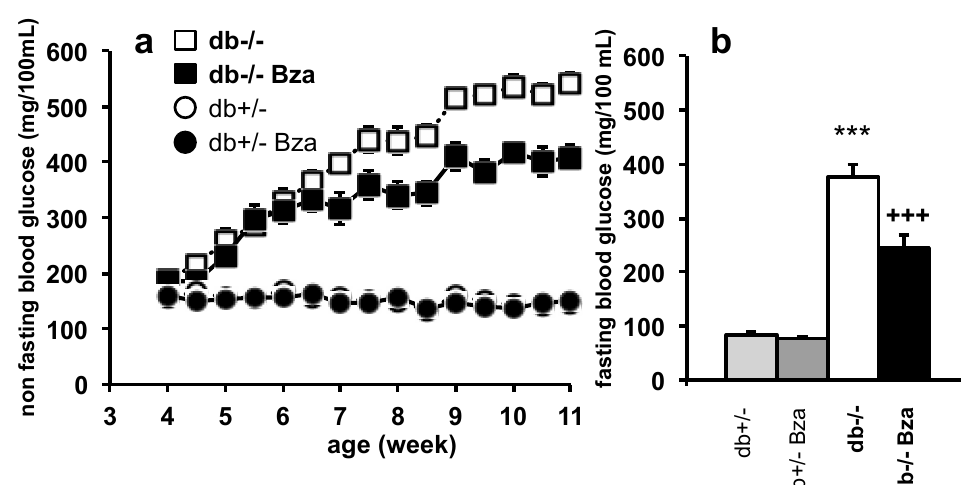
Figure 1. Influence of benzylamine supplementation on non-fasting and fasting blood glucose in db-/- and db+/- mice. Littermates from inbred db+/- mating were separated according to gender and distributed in a group subjected to benzylamine (Bza) at 0.5% in the drinking water (dark symbols) and in a control group with free access to water (open symbols) at week 4. Then at week 6, animals were separated according to their phenotype obese (squares, bold) or lean (circles, plain). ( a ) Non-fasting blood glucose as determined twice a week during 7-week treatment. Statistical analysis is reported in the body text of Results. ( b ) Overnight fasting blood glucose at the end of experiment. Data are means ± SEM of the following numbers of mice: 28 db-/-, 18 Bza-drinking db-/-, 21 db+/-, and 14 Bza-drinking db+/-. Significant difference between db-/- and db+/- at: *** p < 0.001; significant difference between Bza-db-/- and db-/- at: +++ p <0.001.